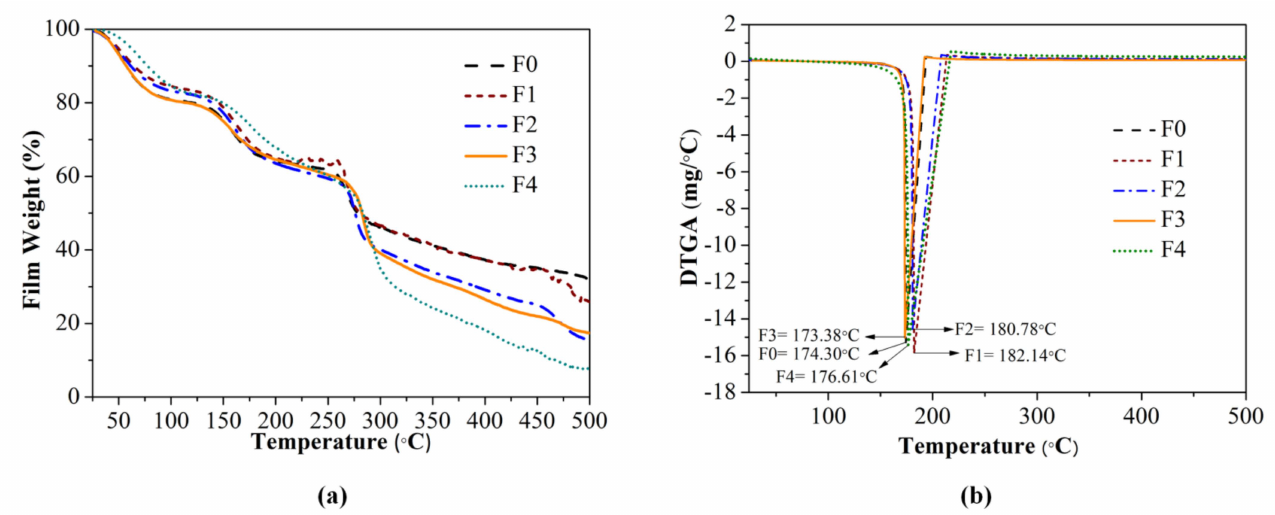
Figure 3. Thermogravimetry analysis (TGA) curve ( a ) and DTGA curve ( b ) of the bionanocomposite and control films. F0: SRiC film (control film), F1: SRiC film with SiO 2 -ZnO nanoparticles, F2: SRiC/CS (1.5 wt%: 0.5 wt%) with SiO 2 -ZnO nanoparticles, F3: SRiC/CS (1.0 wt%: 1.0 wt%) with SiO 2 -ZnO nanoparticles, F4: SRiC/CS (0.5 wt%: 1.5 wt%) with SiO 2 -ZnO